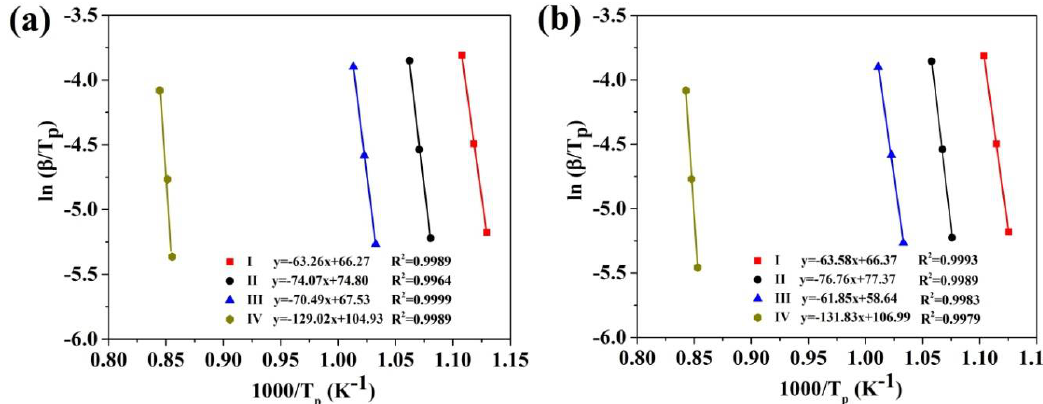
Figure 4. Plots of ln( β/T p ) vs. 1000/ T p for all crystallization stages of (Fe 41 Co 7 Cr 15 Mo 14 Y 2 C 15 B 6 ) 100−x Cu x amorphous alloys; ( a ) x = 0.25 at.%; ( b ) x = 0.5 at.%.